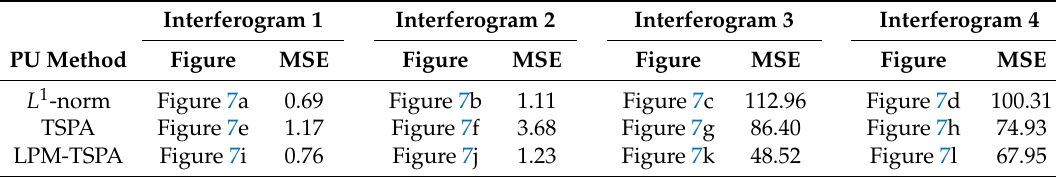
Table 6. Statistical Information of PU Performance in Figure